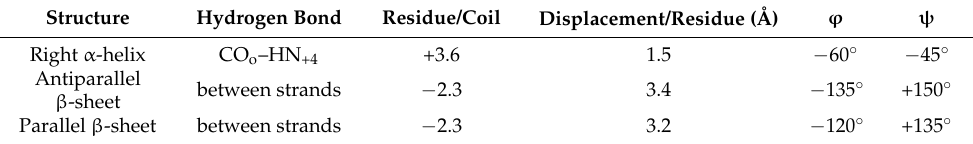
Table 1. Geometric parameters of the elements of the secondary structures of proteins.